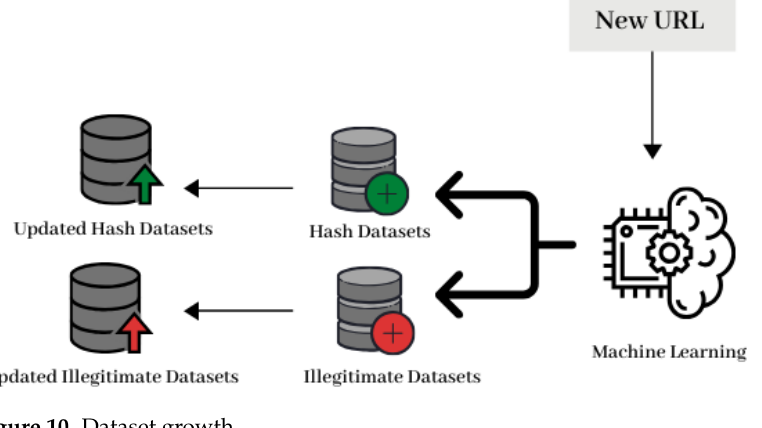
Figure 10. Dataset growth.